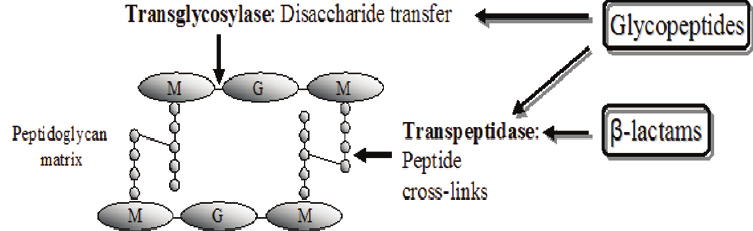
Figure 4. The cell wall (peptidoglycan matrix) surrounding bacterial cells is a mesh-like carbohydrate polymer with glycan strands connected by peptide cross-links. Transglycosylases catalyse cross-linking of the glycan strands, and the peptide strands undergo cross-linking by the action of transpeptidases. Transpeptidases are inactivated by β -lactams and glycopeptides. Glycopeptides also inhibit transglycosylase activity. Interference with cross-linking results in cell lysis and death. M: N -acetylmuramic acid; G: N -acetyl-D-